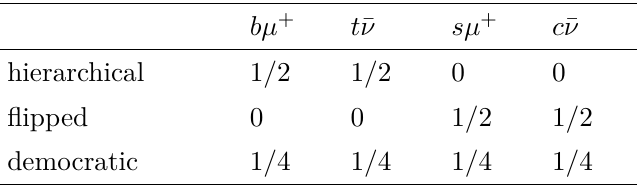
Table 1 . Branching fractions of the V 1 leptoquark and the triplet component V 2 / 3 scenarios from section 2.2.